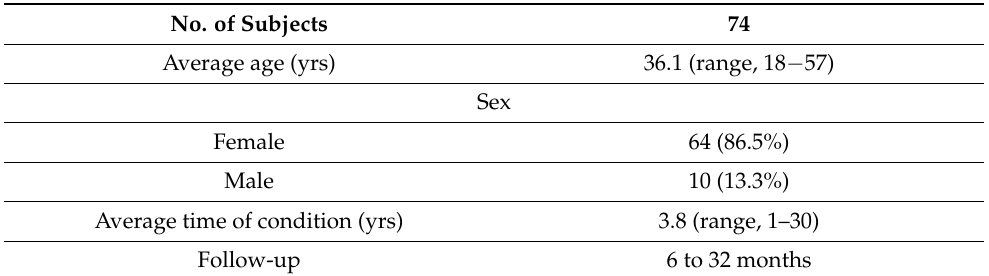
Table 3. Characteristics of patients with periorbital hyperpigmentation treated with lasers and combined procedures.